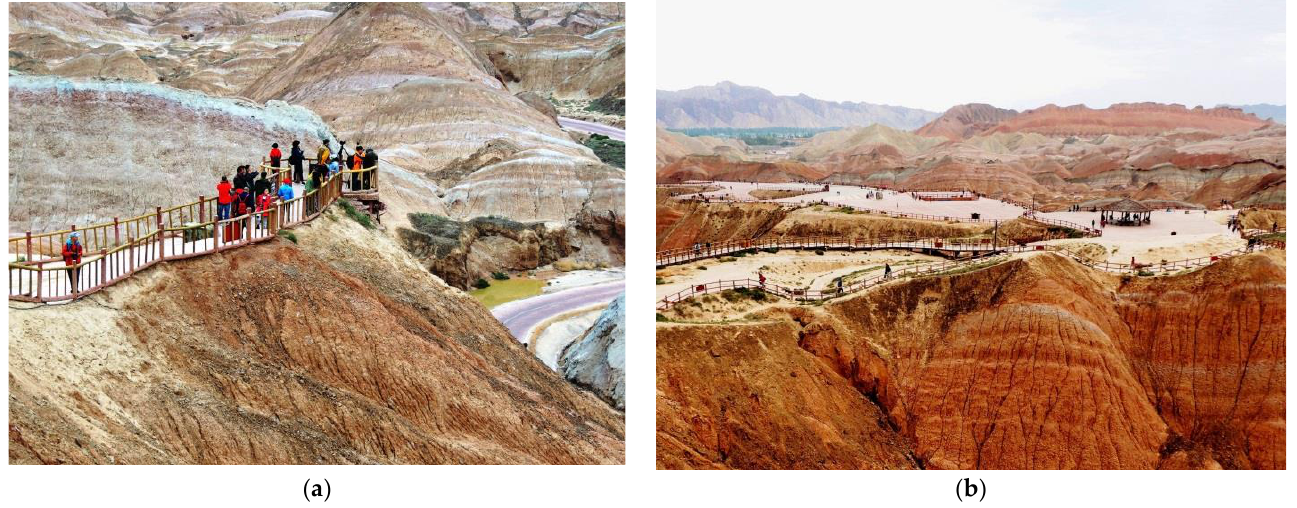
Figure 8. ( a ) The pedestrian paths that rise and fall on the hills of the Danxia of Linze (credit Fabio Fratini); ( b ) the square in an elevated area that can be reached by the same buses and cars in the Danxia of Linze (credit Fabio Fratini) .